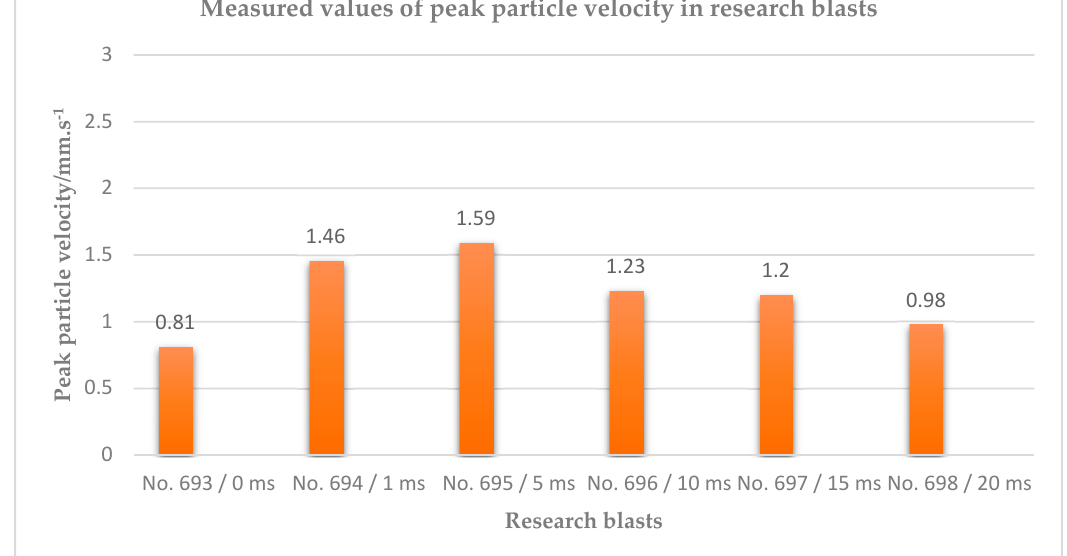
Figure 8. Dependence of measured values of peak particle velocity in research blasts (source: author). Appl. Sci. 2020 , 10 , x FOR PEER REVIEW